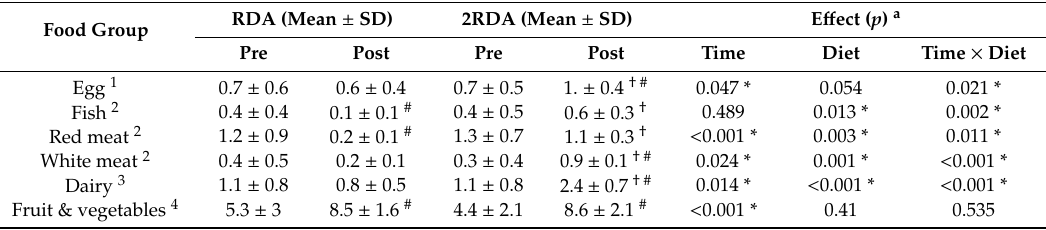
Table 2. Servings per day of egg, fish, red meat, white meat, dairy intake, and fruit and vegetables for the RDA and 2RDA groups pre- and